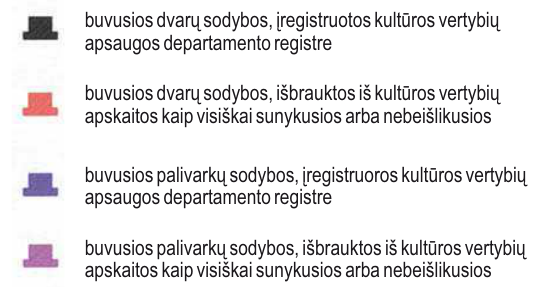
Fig 2. Spread of estates and historic parks over Lithuanian seacoast: